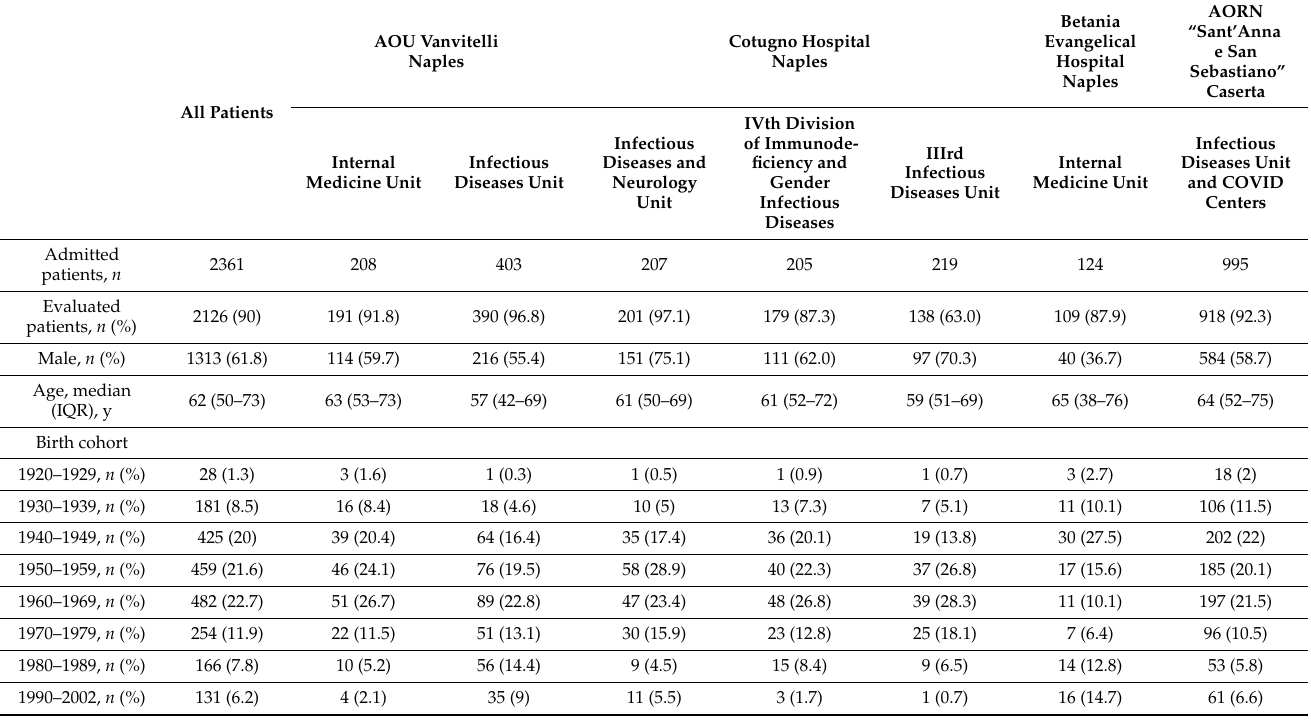
Table 1. Demographic characteristics of the screened population, overall and by single Center.